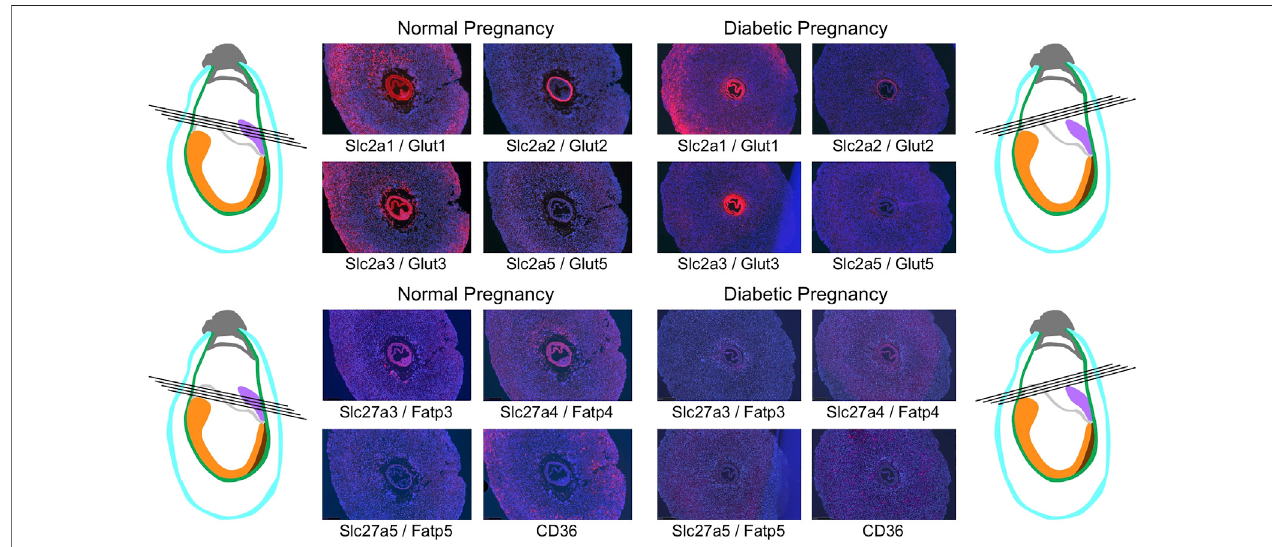
FIGURE 6 | Comparison of nutrient transporter expression in decidua of normal and diabetic pregnancies at E7.5. Decidua from normal and diabetic pregnant females of the NOD mouse strain were isolated at E7.5, and serial sections were produced; their orientations are indicated by black lines. The color code for the schematic representations is the same as for Figures 4 , 5